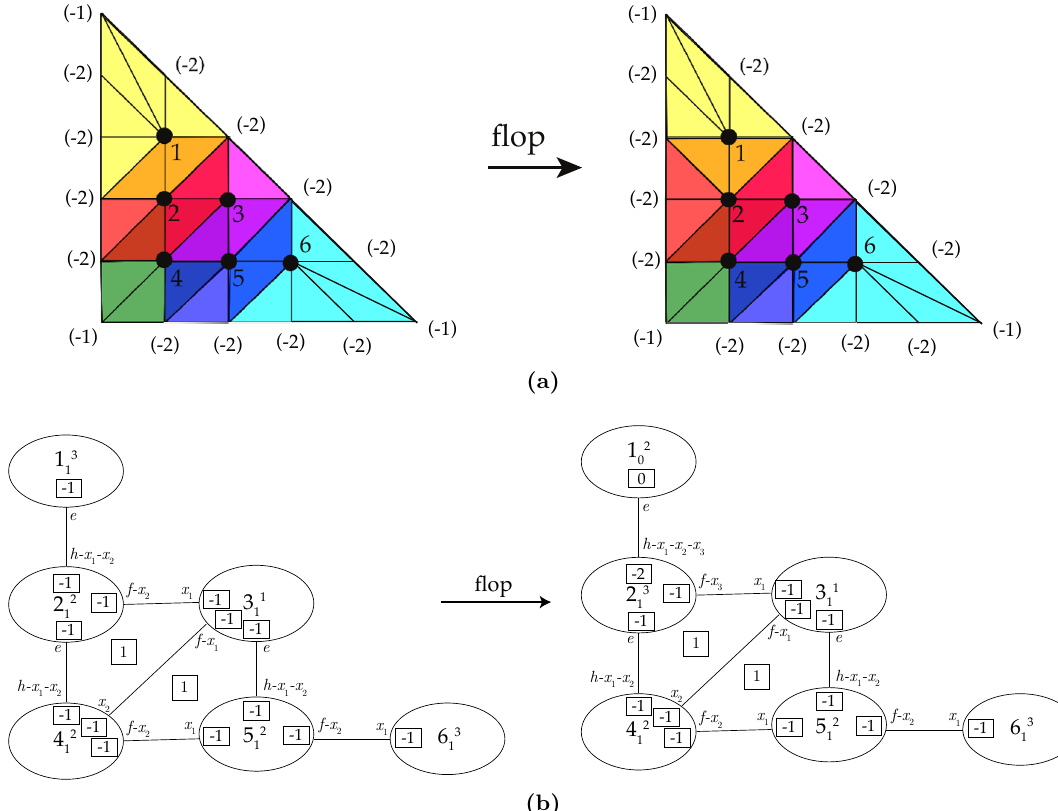
Figure 4 . (a) An example of toric (cid:13)op of the resolved T 5 geometry among the compact